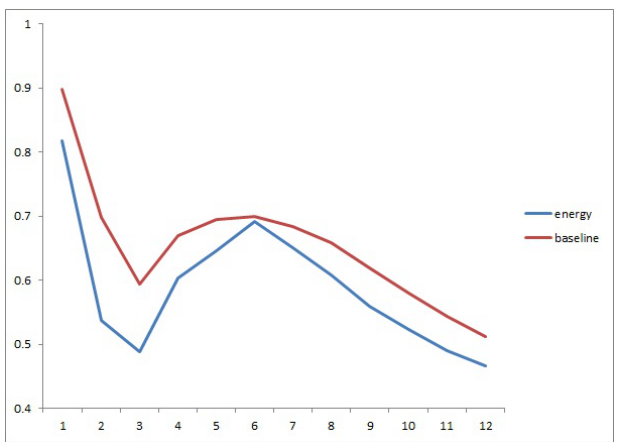
Figure A9. Comparison between probability of positive responses: Energy and aggregate responses.